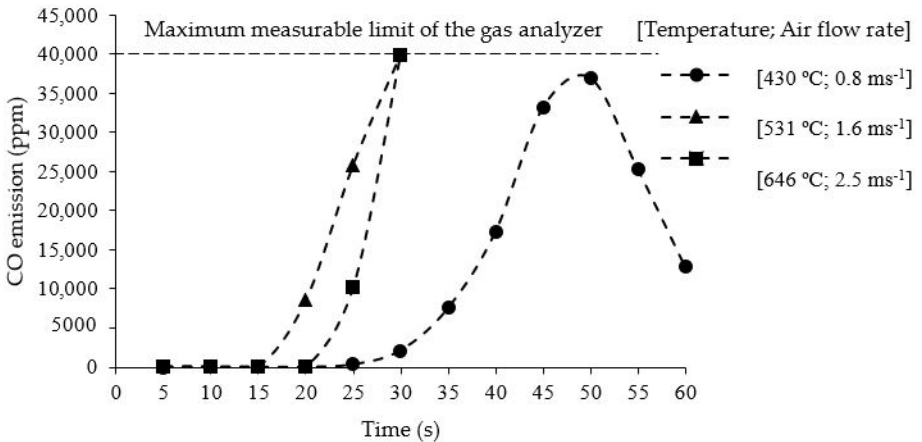
Figure 7. The CO emission trend from the combustion of rice husk after the hot air preparation stage.